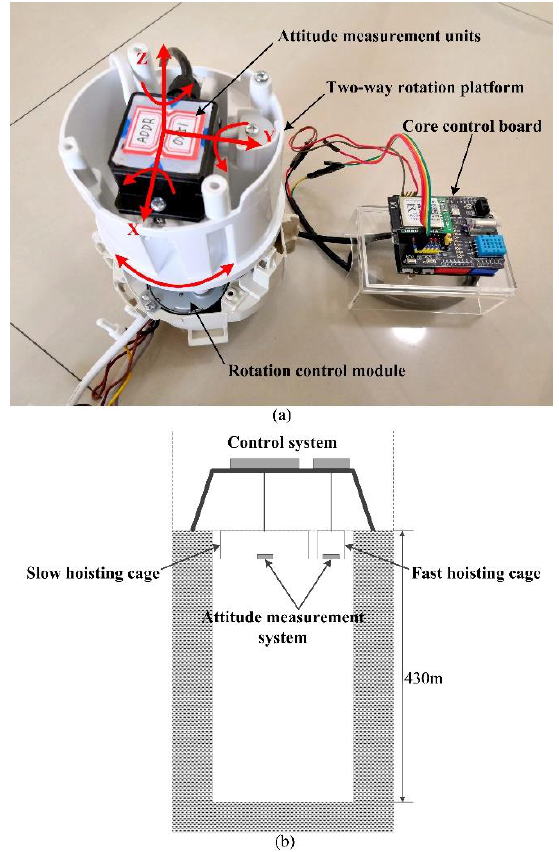
Figure 14. ( a ) Experiment equipment of dynamic response; ( b ) experimental environment of vertical tracking.